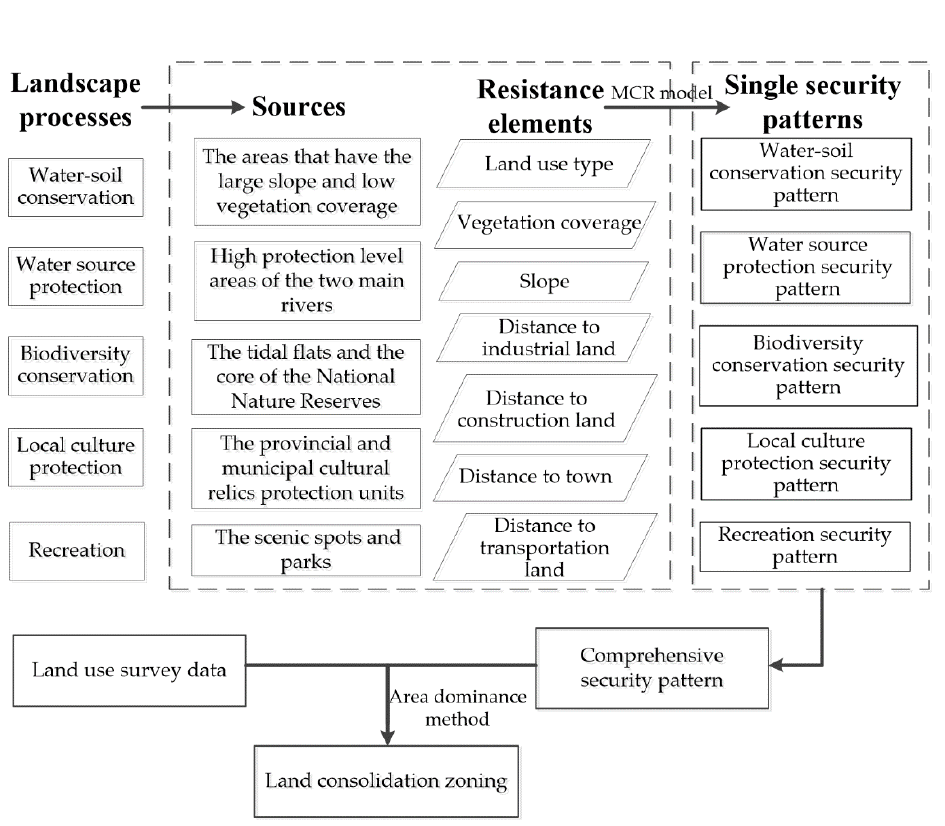
Figure 2. The workflow for land consolidation zoning in coastal tidal areas based on landscape security patterns .